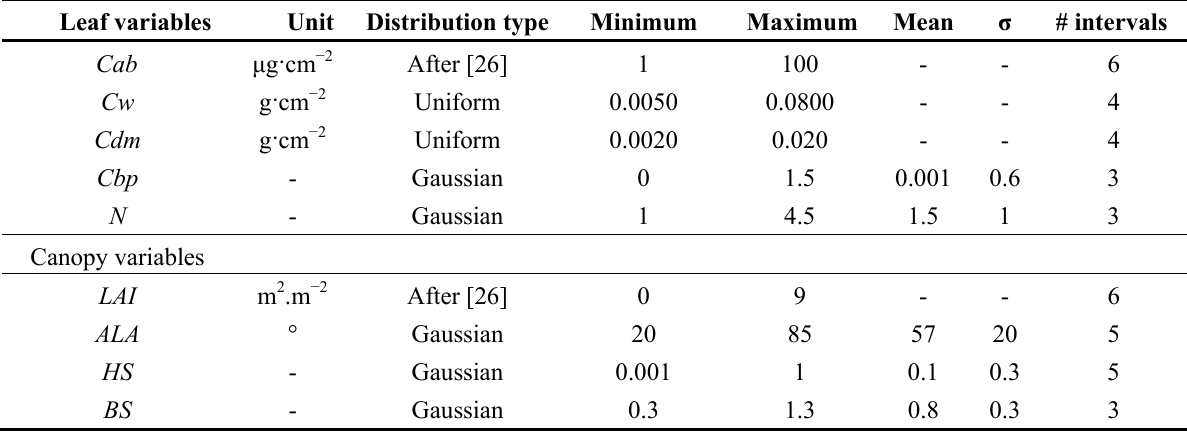
Table 3. Distribution and sampling plan of the input variables used to construct a comprehensive LUT matching all agricultural land cover